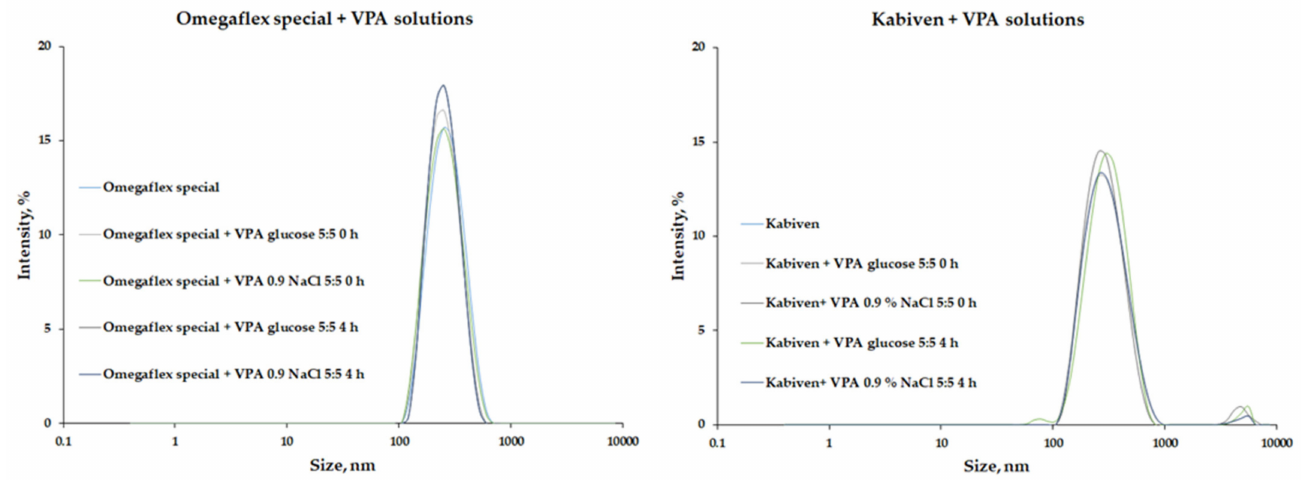
Figure 2. Results of size distribution for Omegaflex special (samples without second fraction) and Kabiven (samples with second fraction of lipid droplets higher than 1000 nm). VPA—sodium